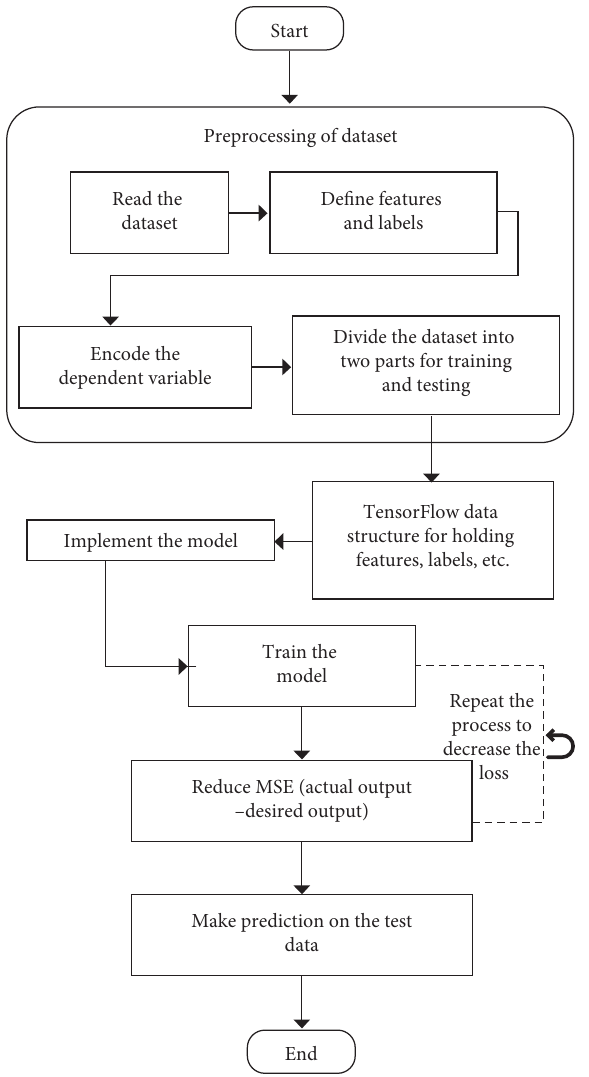
Figure 1: Steps involved in implementing the TensorFlow use